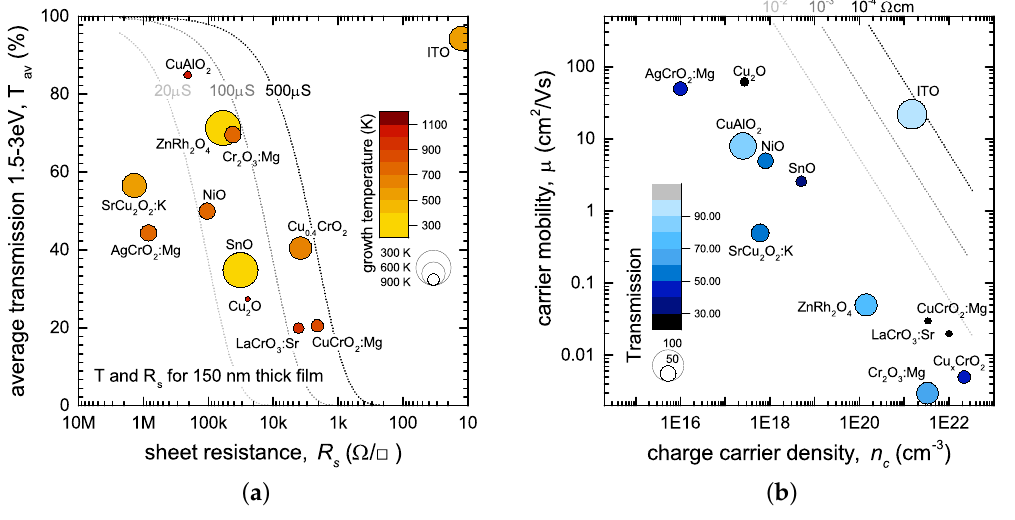
Figure 1. ( a ) Comparison of the literature data of average transmission and sheet resistance of a range of p-type transparent conducting oxides (TCOs). The reported literature data have been adjusted to account for varying thickness between samples, and the average transmission was taken over an energy range of 1.5–3eV. Dotted lines indicate “constant figure of merit” lines. The size of the points scales inversely with growth temperature (or post-annealing temperature if required), as excessive temperature also hampers the ability of materials to be successfully used in applications; ( b ) The reported carrier concentration and hole mobility for the same set of samples, with the size of the point proportional to the transparency. Lines of equal resistivity are shown, illustrating the poor performance of today’s p-type TCOs compared to ITO (Data sources are listed in Table